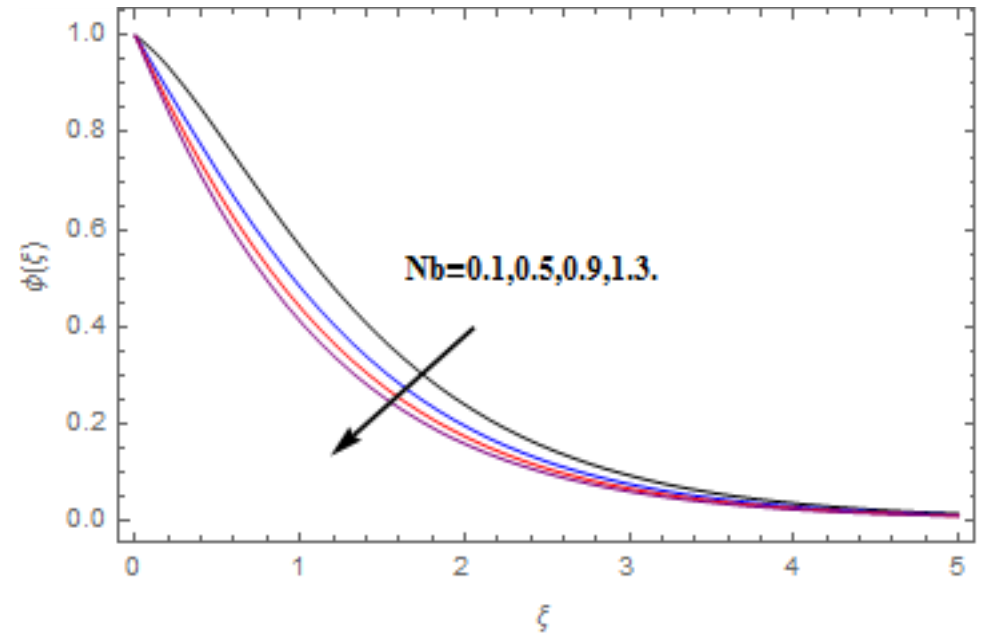
φ ( ξ ) against Nb , when M = ψ = 0.2, Nt = 0.5, Le = 1.0, Ec = 1.0, Pr = 1.2,